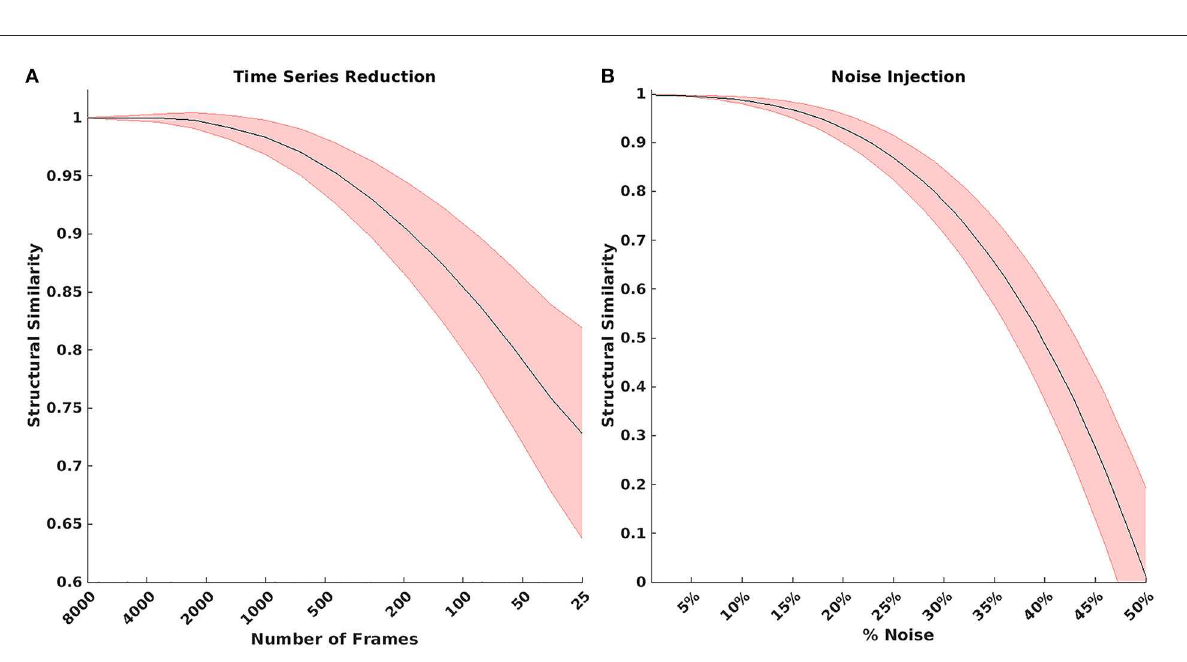
projected onto the cortical surface, and Figure 2B shows the mean voxelwise RSN membership probability maps for each network (0.2 threshold). Supplementary Figure